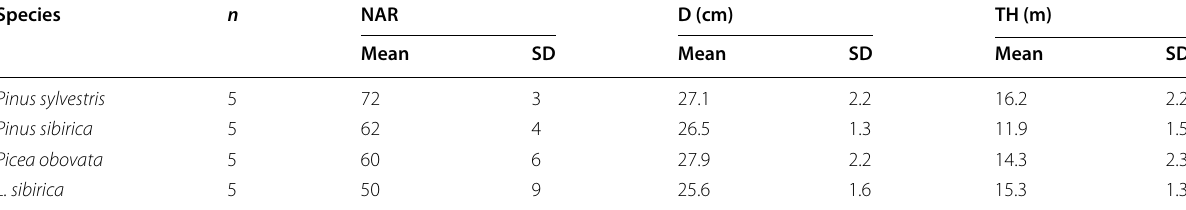
Table 1 Number of annual rings, stem diameter, and tree height of sample trees Species n NAR